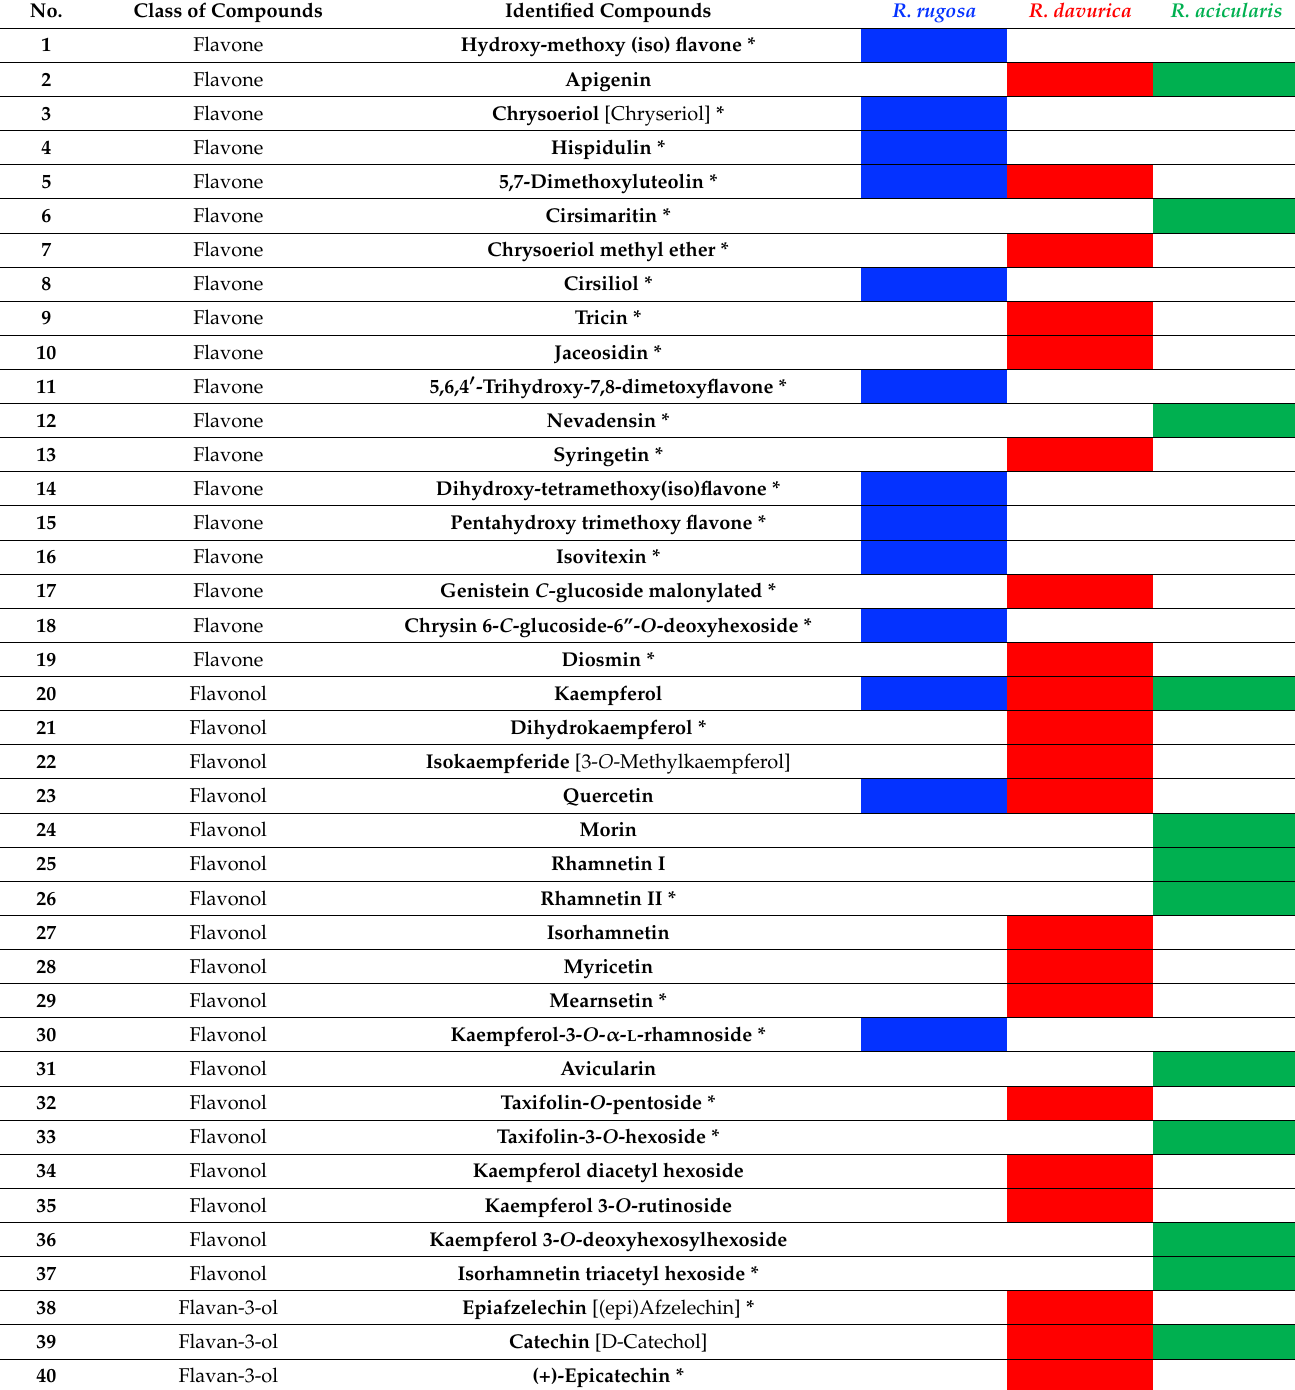
Table 1. The flavonoid composition distribution of varieties R. rugosa Thumb., R. davurica Pall., and R. acicularis Lindl. Blue square—presence in extracts of R. rugosa ; red square—in extracts of R. davurica ; green square—in extracts of R. acicularis